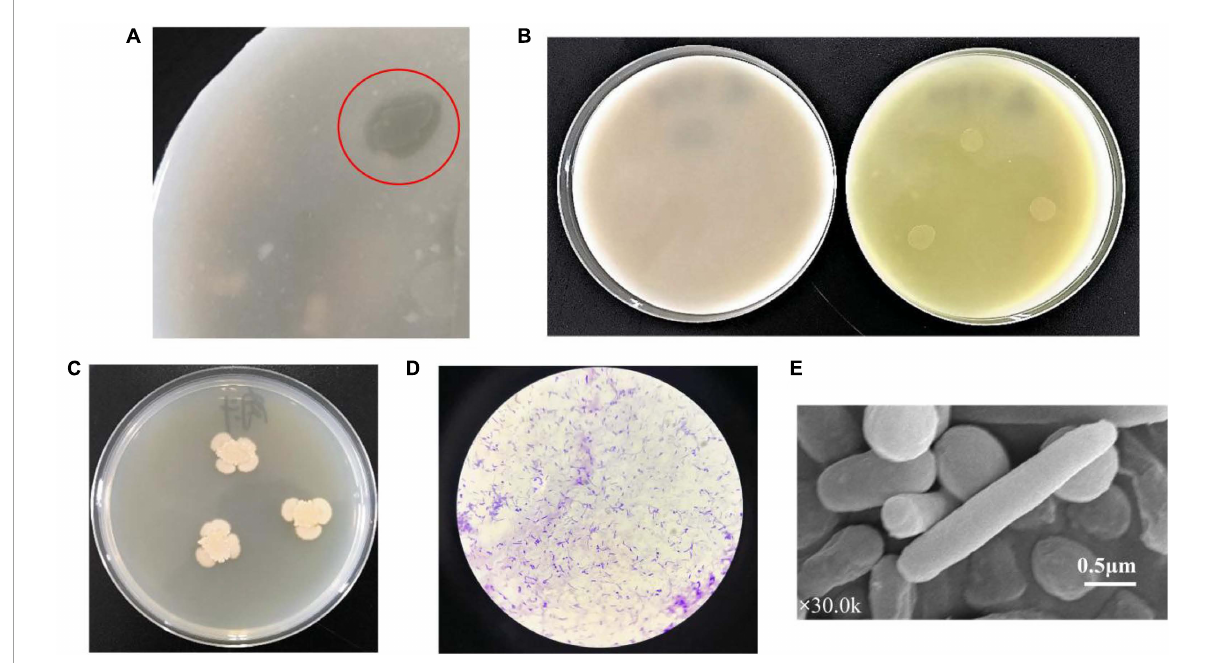
FIGURE1 Morphological andfeatures of strain TCI-16. (A) After incubation at 30 ◦ C for 48 h, TCI-16 hydrolyzed colloidal chitin and formed transparent circles on the selective medium; (B) after incubation at 30 ◦ C for 48 h, CDA producing colonies reacted chromogenically and exhibited yellow circles in the differential medium (right), but the control was unchanged (left); (C) after incubation at 30 ◦ C for 48 h, colony morphology of the TCI-16 strain in LB medium; (D) gram staining; (E) SEM image ( × 30.0k).